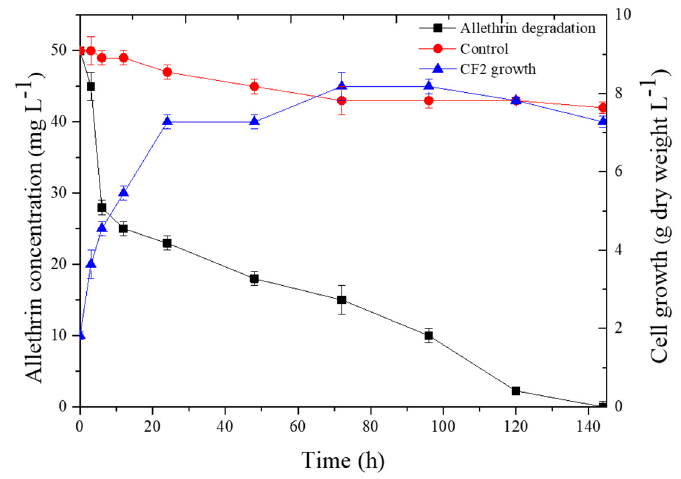
Figure 6. Growth curves of strain CF2 and allethrin degradation profiles over time. The data presented are mean ± standard errors of three independent experiments.